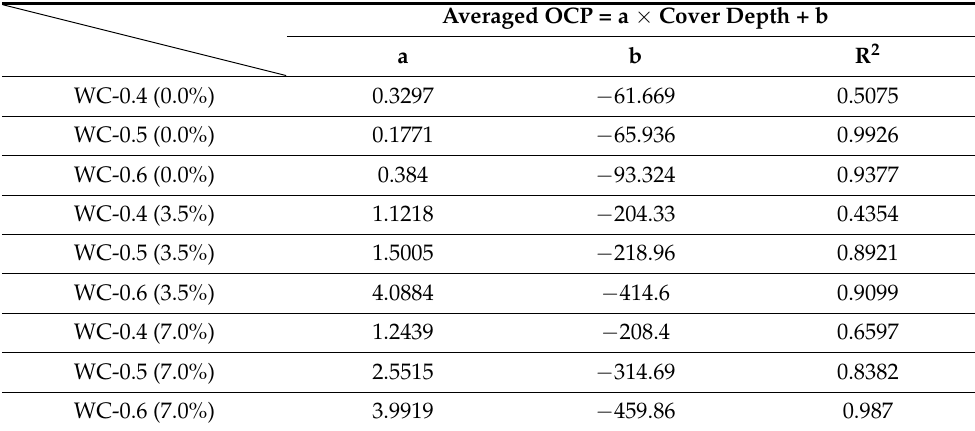
Table 5. Gradient analysis of the cover depth effect on the open-circuit potential